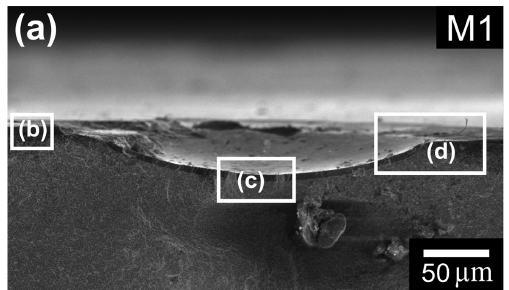
Figure 6. Cross-section profiles of impact craters after different impact cycles on AlCrN coatings. Horizontal dashed grey lines denote the position of the surface of coatings and the coating/substrate interface.